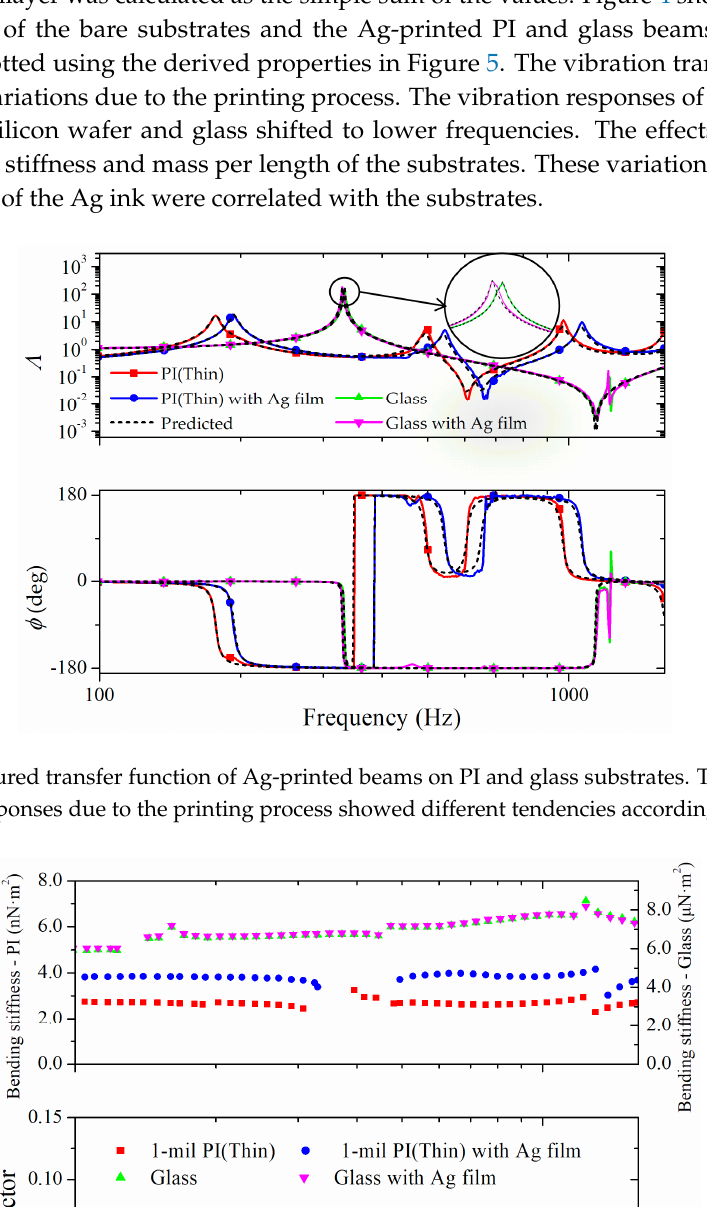
Figure 6. Young’s moduli and loss factors of the inkjet-printed Ag film on various substrates. The mechanical properties of the ink varied considerably depending on the substrate. These tendencies suggest the effect of the substrate should be considered to accurately obtain the properties of the ink. 4. Conclusions The proposed method based on the wave approach was introduced to measure the Young’s modulus and loss factor of inkjet-printed Ag thin films on various substrates. The effect of the substrate on the properties of the printed films was discussed with respect to the morphology of the film. The vibration transfers of the printed film were compared according to substrate. Alterations of the vibration responses due to the printing process showed different tendencies. The vibration transfers on the inkjet-printed substrates were analyzed using the bilayer beam. The bending stiffness and loss factor of the printed beam were obtained numerically. Through the proposed method, the Young’s modulus and loss factor of the ink were determined for various substrates. The dynamic properties of the ink varied considerably according to the substrates. When the thickness of the Ag film decreased under the identical sintering condition, the Young’s modulus and the loss factor increased. The Young’s moduli of the Ag films on the substrates were measured to be 46.4–90.8% of that of silver. The loss factor tended to increase with the increment of the modulus. The proposed method reliably determines the dynamic properties of the thin film regardless of the substrate characteristics. The Young’s modulus and loss factor were directly determined using the vibration response on the bare substrate and the bilayer without any damage